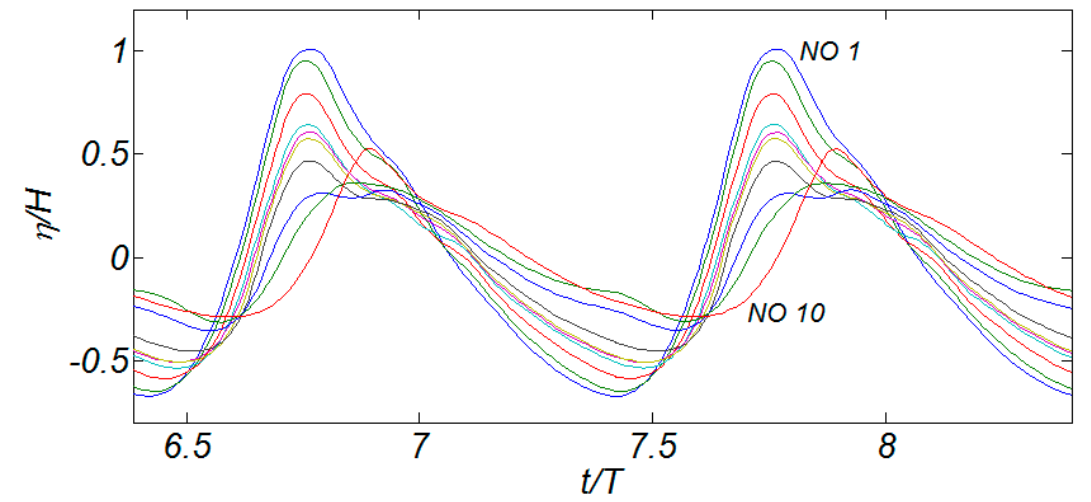
Figure 15. Time series of numerically simulated water surface elevation around the mono-pile.